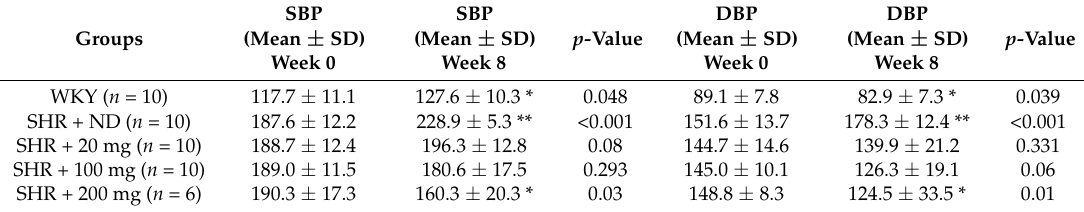
Table 1. Changes in SBP and DBP during eight weeks in the study groups